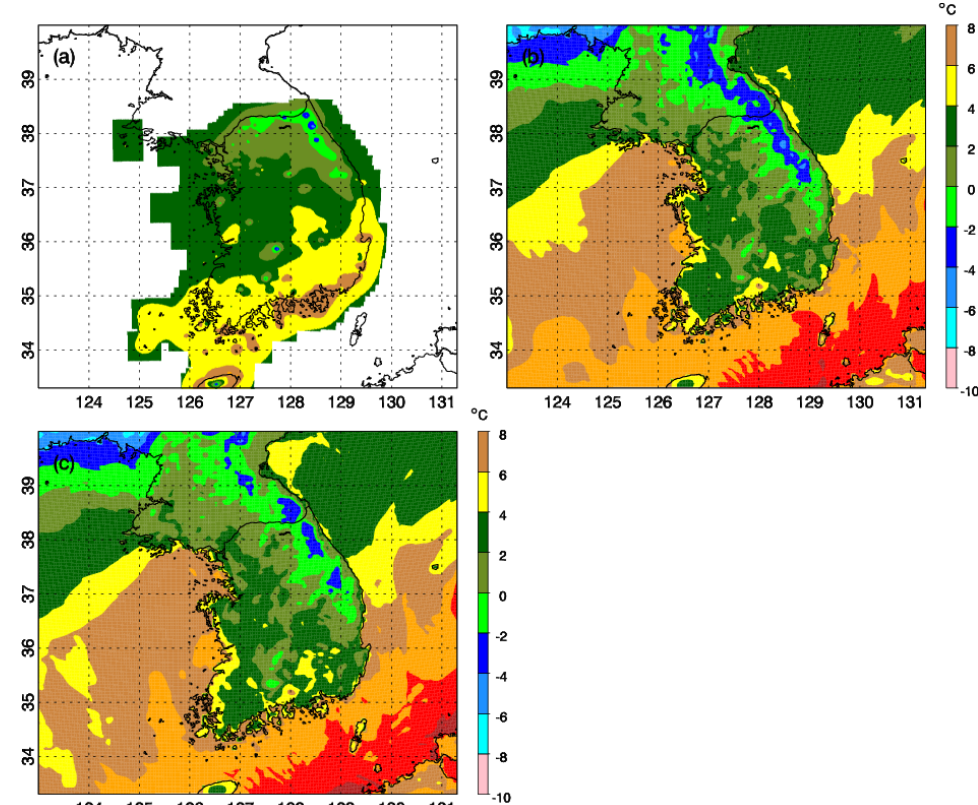
Figure 13. The 2m temperature field ( ◦ C) from (a) South Korean Surface Analysis, (b) CTRL_Feb, and (c) DA_Feb at 18:00UTC 28 Febru- ary